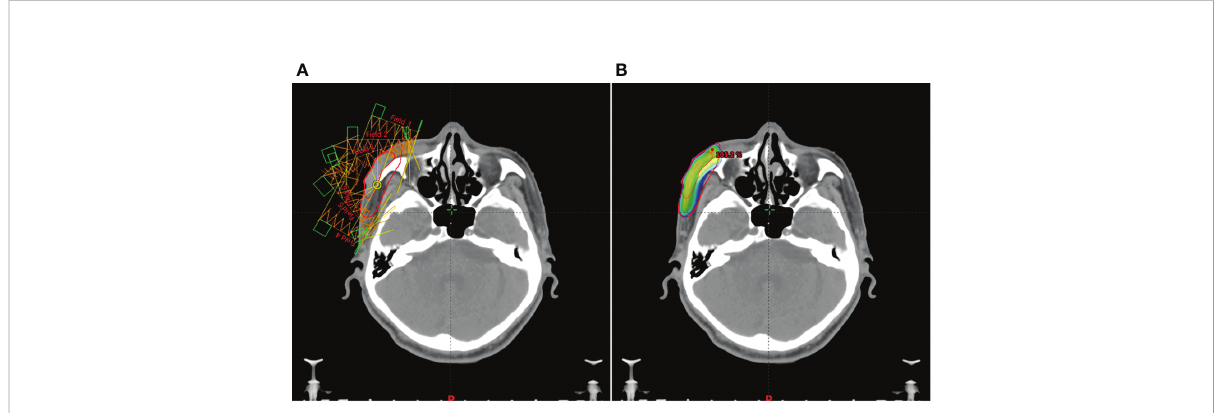
FIGURE 4 The patient ’ s IMRT treatment plan. (A) , In order to make each part of the lesion receive uniform irradiation, we used IMRT treatment plan with 6 radiation fi elds. (B) , The red line on the outer layer represents the area to be irradiated, and the gradient color image from blue to red represents the 100% prescription dose range. It can be seen that the two are highly consistent.